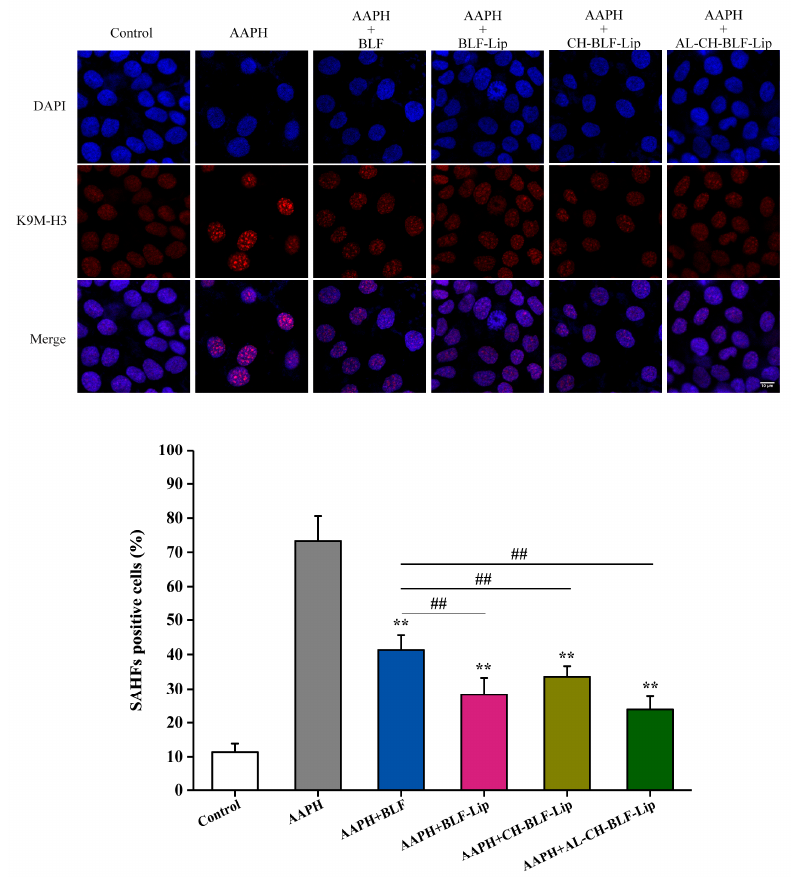
Figure 8. Representative images of SAHF formation. Scale bar = 10 μ m. The percentage of SAHF positive cells was shown below. Data were presented as mean ± SD of three independent replica- tions. ** p < 0.01 vs. AAPH group, ## p < 0.01 vs. AAPH + BLF group. BLF, bamboo leaf flavonoids; BLF-Lip, BLF-loaded nanoliposomes; CH-BLF-Lip, BLF-loaded chitosan coated nanoliposomes; AL- CH-BLF-Lip, BLF-loaded alginate-chitosan coated nanoliposomes; AAPH, 2,2 ′ -Azobis (2- methylpropionamidine) dihydrochloride.